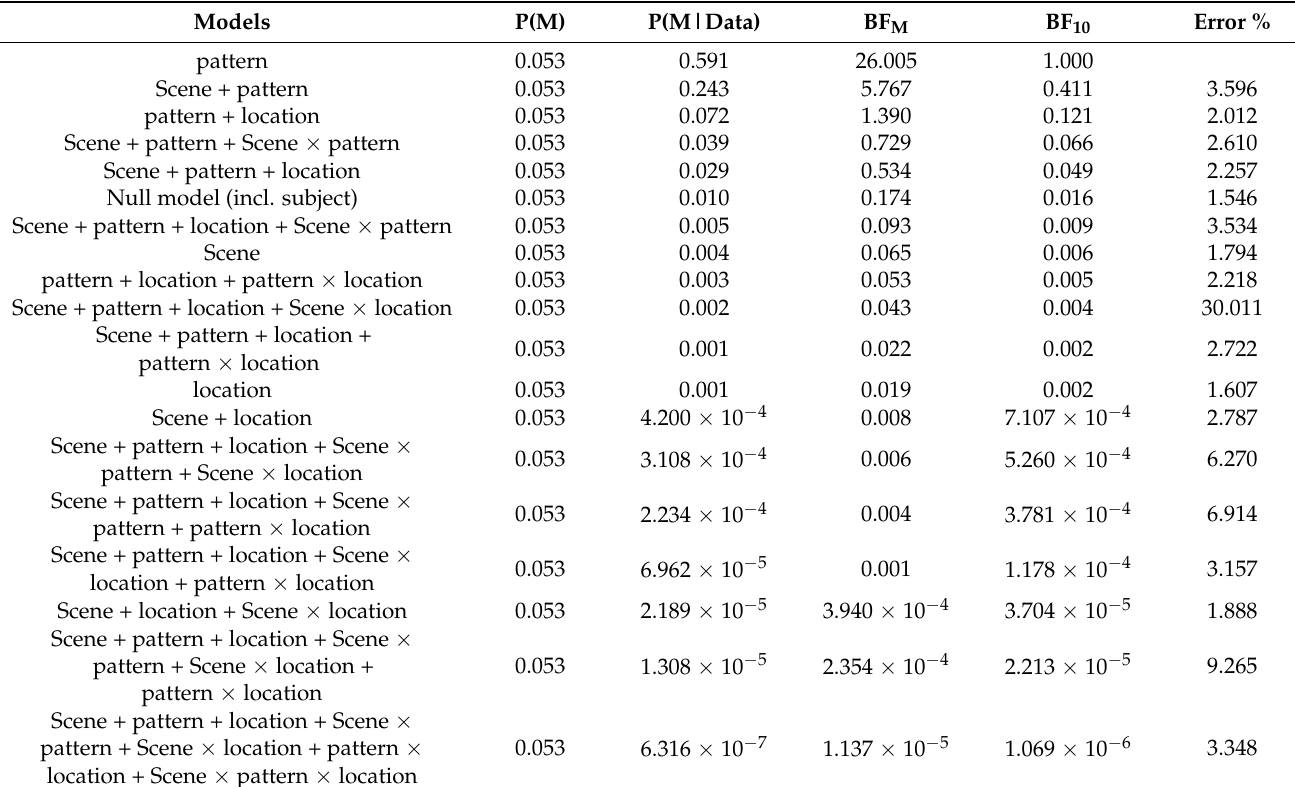
Table 4. Model comparison using Bayesian rmANOVA in the late component.